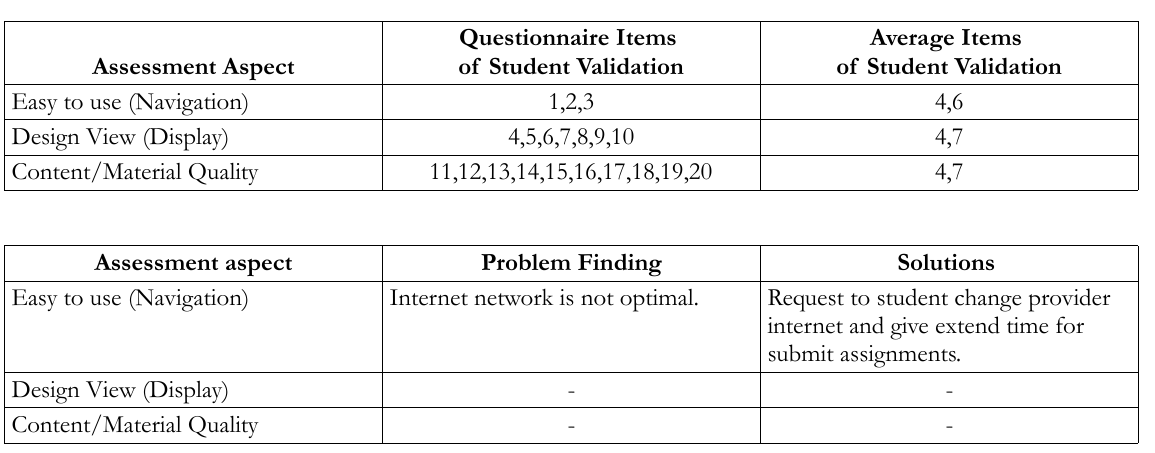
Table 7. Results of small group